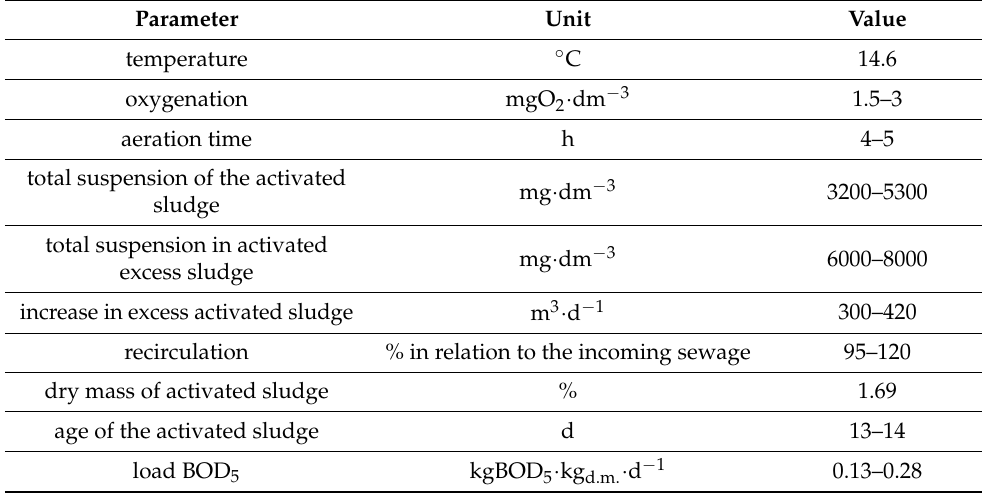
Table 1. Technological parameters of the activated sludge used for the research at the Municipal and Industrial Sewage Treatment Plant in